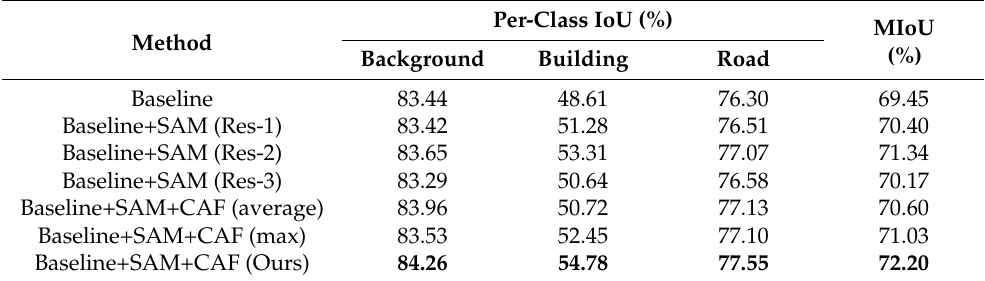
Table 4. Module validity analysis based on CITY-OSM dataset. (Data in bold are the best